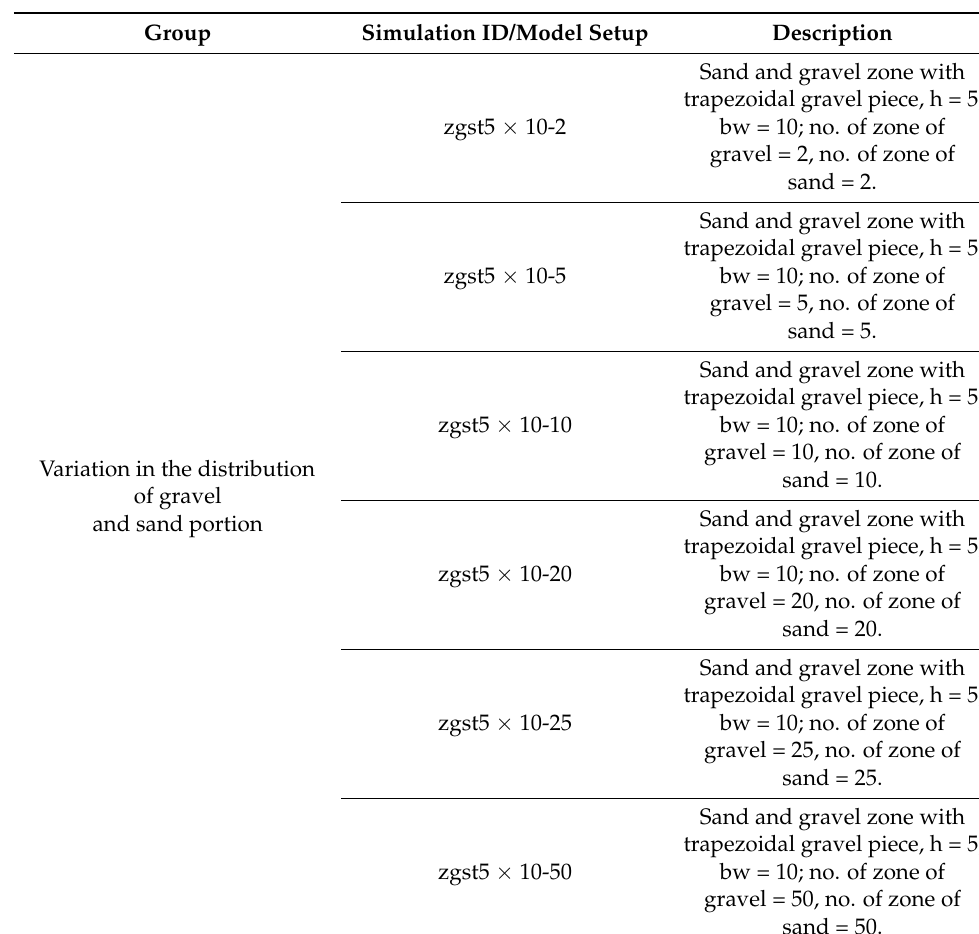
Table 3. ID and description of the model setups for the analysis of the effect of variation in distribution of gravel and sand portion over hyporheic